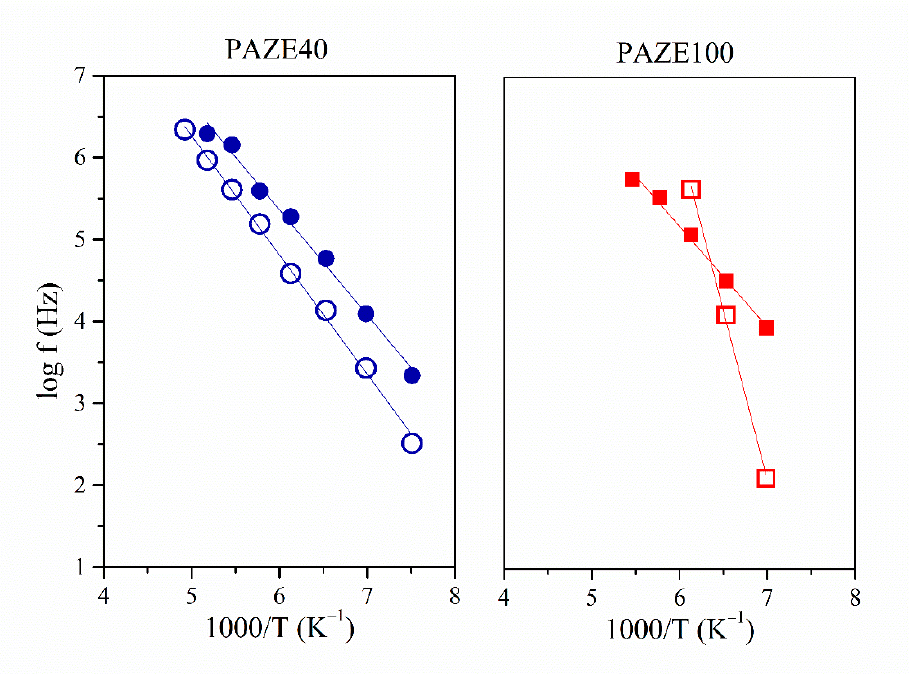
Figure 12. Detail of the Arrhenius maps of the γ relaxation of PAZE100 and PAZE40 for unor- iented (full symbol) and oriented (hollow symbol) copolymers.